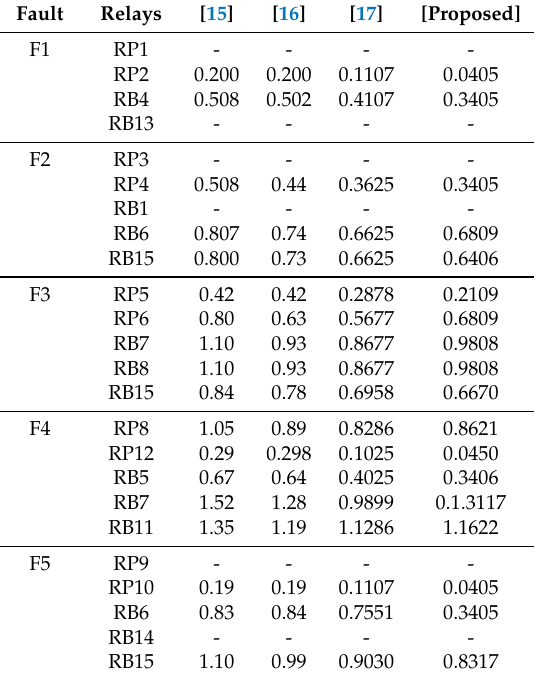
Table 9. Operation times for